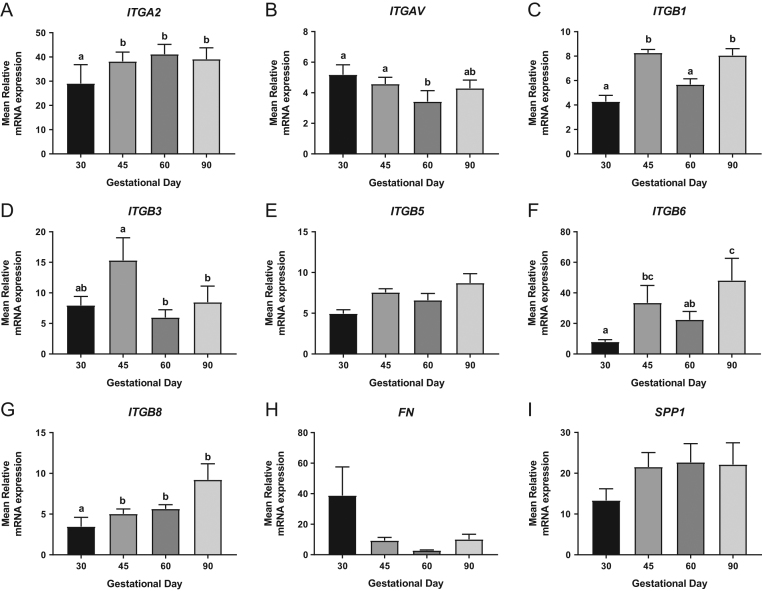
Integrin mRNA expression in placental tissues on days 30, 45, 60 and 90 of pregnancy. mRNA expression of ITGA2 (A), ITGAV (B), ITGB1 (C), ITGB3 (D), ITGB5 (E), ITGB6 (F), ITGB8 (G), FN (H) and SPP1 (I) in placental samples at GD30, 45, 60 and 90. Error bars represent s.e.m. n = 9–23 foetuses/GD.